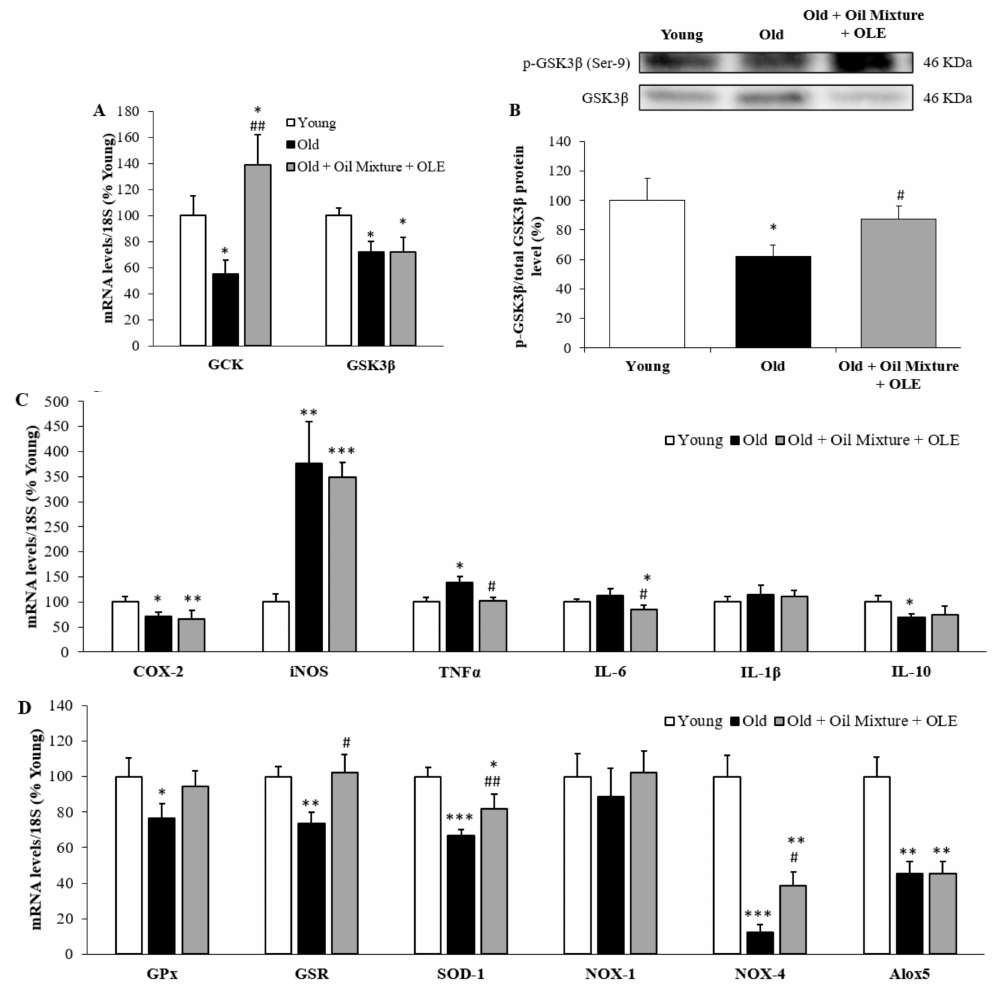
Figure 2. Hepatic mRNA concentrations of Glucokinase and Glycogen synthase kinase 3 β ( A ), protein ratio between p-GSK3 β and GSK3 β ( B ); and mRNA concentrations of cyclooxigenase-2, inducible Nitric Oxide Synthase, Tumor Necrosis Factor α and Interleukin 6 and 1 β ( C ) and of Glutathione Peroxidase and Reductase, Super Oxide Dismutase 1, NADPH oxidase 1 and 4 and Lipoxygenase ( D ) of young rats, old rats and old rats treated 21 days with the Oil Mixture and the OLE. Values are represented as mean ± SEM. * p < 0.05 vs. Young; ** p < 0.01 vs. Young; *** p < 0.001 vs. Young; # p < 0.05 vs. Old; ## p < 0.05 vs.